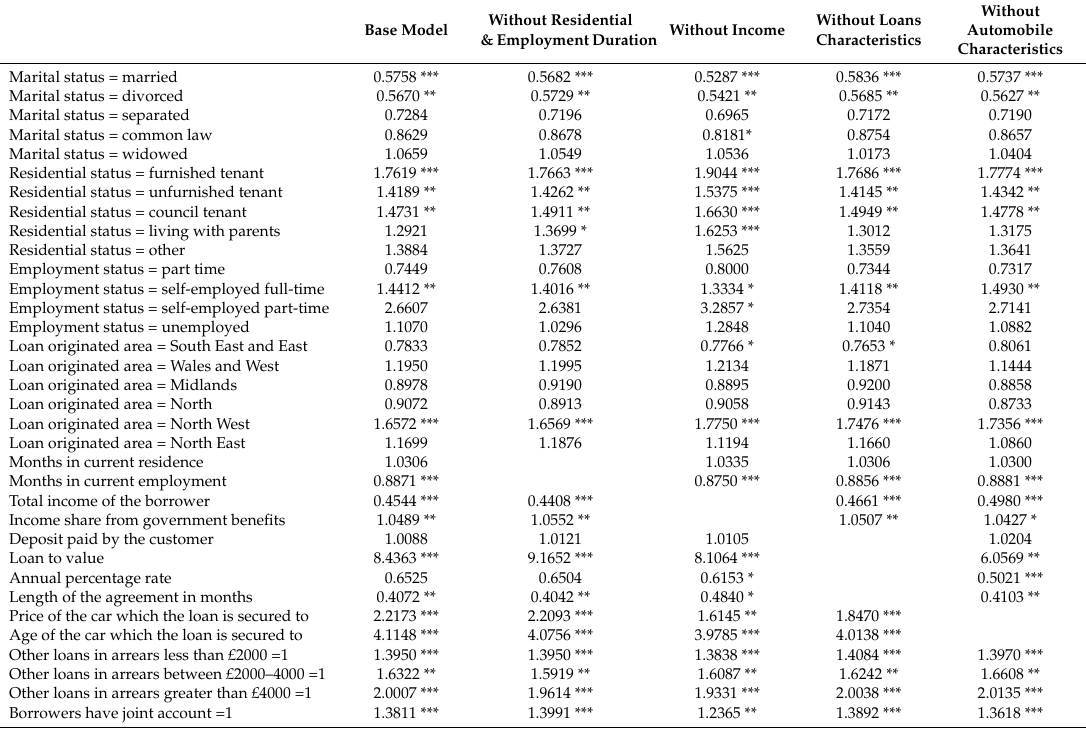
Table 4. Subprime automobile loans: determinants of defaults (odds